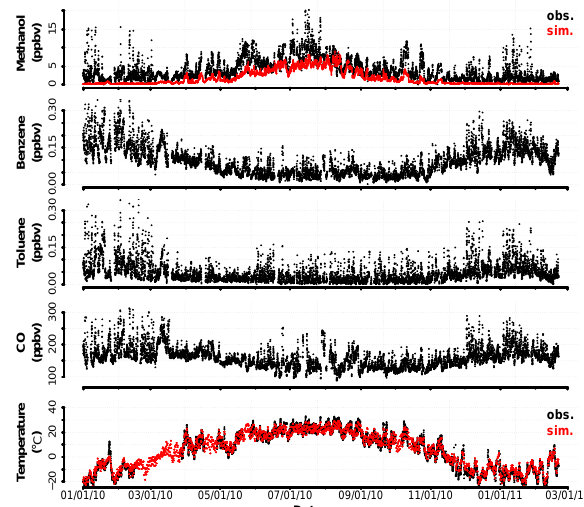
Fig. 3. Annual cycle in methanol, benzene, toluene, CO and air temperature observed at the KCMP tall tower from January 2010 through February 2011 (black). Methanol concentrations simulated by GEOS-Chem are shown in red, as are the assimilated tempera- tures used to drive the model. All data points are 1h means. For all compounds statistical outliers ( > 0.98 quantile for each month) have been removed prior to